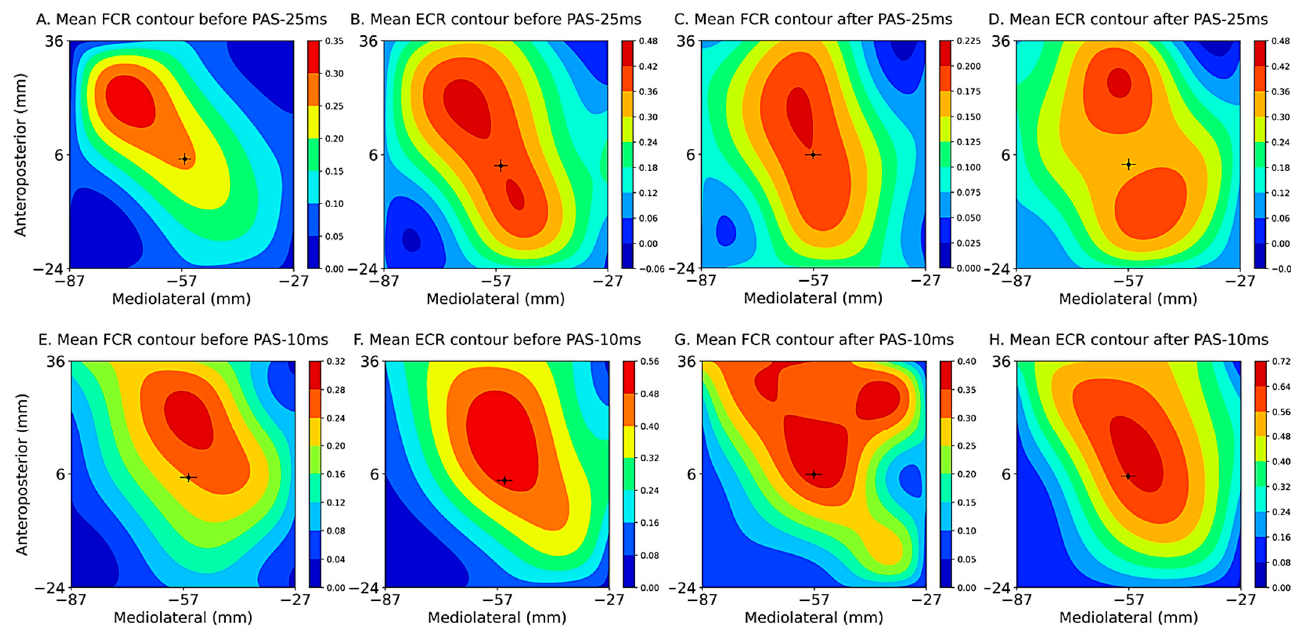
Figure 1. Mean contours of the FCR ( A ) and ECR ( B ) muscles before PAS-25 ms, those of FCR ( C ) and ECR ( D ) muscles after PAS-25 ms, those of the FCR ( E ) and ECR ( F ) muscles before PAS-10 ms, and those of the FCR ( G ) and ECR ( H ) muscles after PAS-10 ms. The color code of each contour denotes the MEP amplitudes. Black circles denote the mean CA , and the error bar denotes the SEM. The vertex (Cz) reflects the coordinate origin. FCR, flexor carpi radialis; ECR, extensor carpi radialis; PAS-25 ms, paired associative stimulation with a 25-ms interstimulus interval between peripheral electrical stimulation and TMS; PAS-10 ms, paired associative stimulation with a 10-ms interstimulus interval between peripheral electrical stimulation and TMS; MEP, motor evoked potential; SEM, standard error of the mean. Table 1. Center of amplitude of peak-to-peak MEP amplitudes before and after PAS.